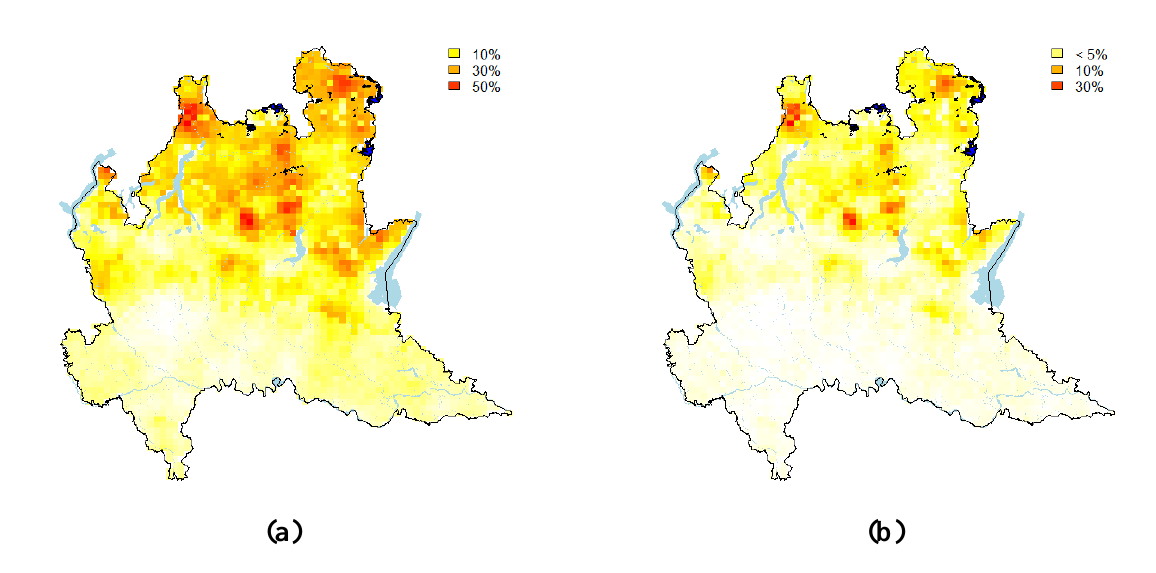
Figure 8. (a) Probability maps for the reference values of 200 Bq/m 3 . (b) Probability maps for 400 Bq/m 3